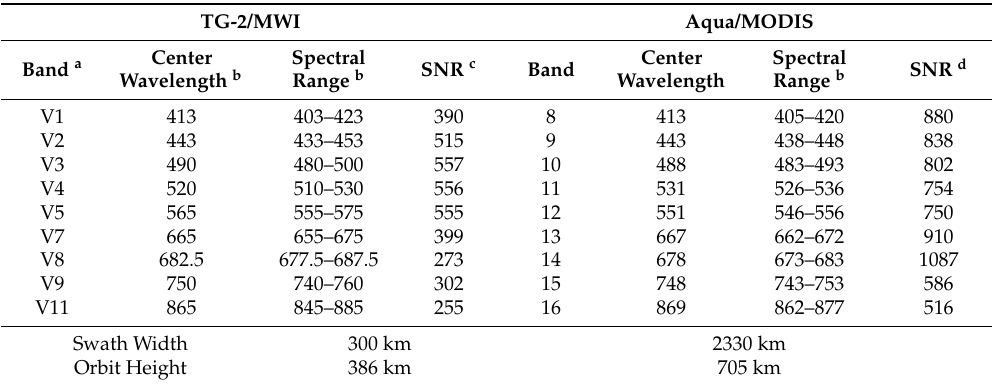
Table 1. Comparison between Moderate-resolution Wide-wavelength Imager (MWI)/Tiangong-2 (TG-2) and Moderate Resolution Imaging Spectroradiometer (MODIS)/Aqua bands.